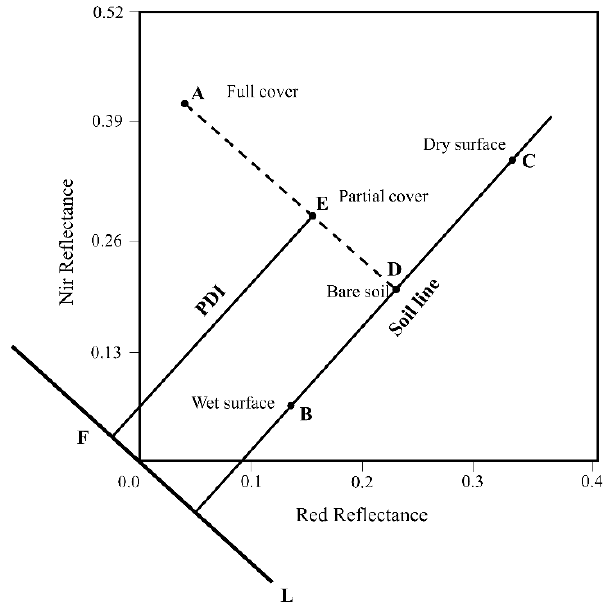
Figure 4. The definition of PDI, the PDI value is defined as the distance of E and F in the NIR–Red spectral space